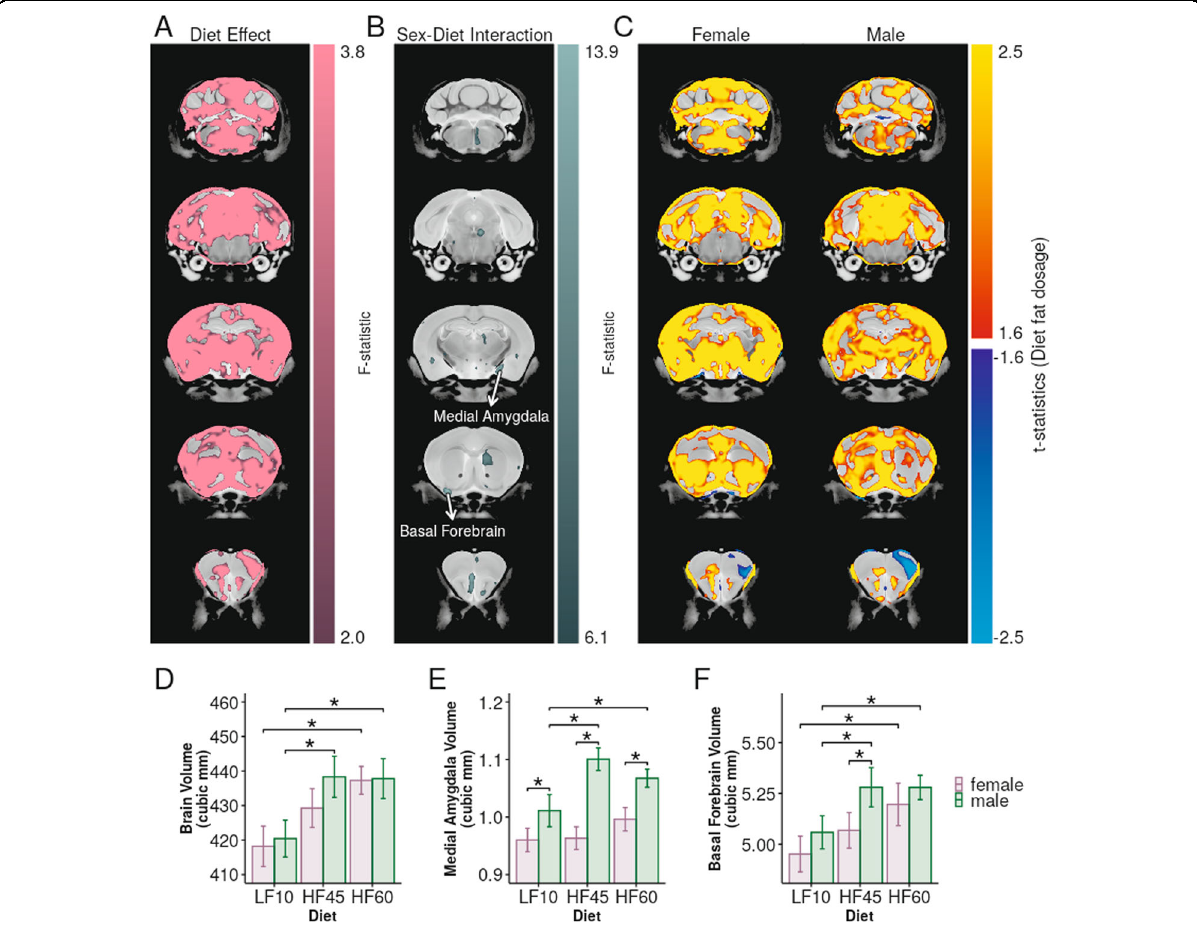
Fig. 4 Offspring exposed to early-life high-fat diet exhibit extensive structural brain changes in adulthood. A Early-life high-fat diet was found to affect the volume of several regions throughout the brain. B In some brain regions, the effect of diet was modulated by sex. C Regional brain volume was largely correlated with early-life dietary fat-percentage (red/yellow colour scale), with some regions, such as the primary motor cortex, showing negative correlations (blue/turquoise colour scale). D Total brain volume was affected by early-life diet ( F 2,95 = 24, p < 10 − 8 ). Volumes of the medial amygdala ( E ) and the basal forebrain ( F ) were strongly impacted by diet ( F 2,95 = 13, p < 10 − 4 , FDR < 10 − 4 and F 2,95 = 14, p < 10 − 5 , FDR < 10 − 4 respectively). The medial amygdala as a whole did not have signi fi cant sex-diet interactions ( F 2,95 = 8.9, p < 10 − 3 , FDR = 0.051). Colour bars show 5% FDR at saturation and extend to 20% FDR to allow visualisation of cluster extent. Error bars represent 95% con fi dence intervals. Asterisks represent signi fi cant group comparisons ( p < 0.05). Volume and effect-sizes for all brain structures are reported in Table